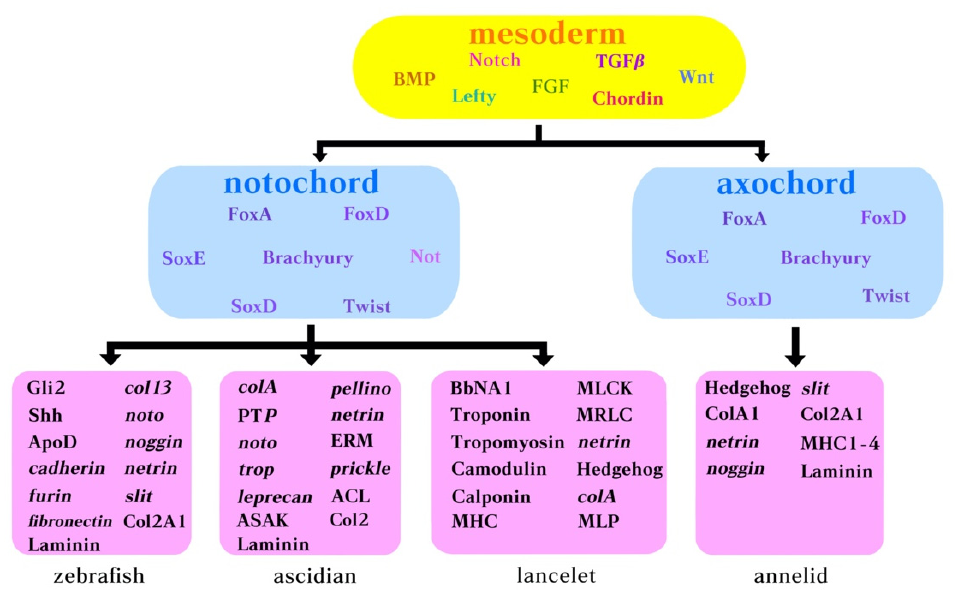
Figure 3. Molecular components belonging to the notochord GNR in ascidians, amphioxus and annelids. Yellow box: body morphogens acting early during development. Pink box: genes expressed by the notochord in zebrafish, ascidian, lancelet (amphioxus), and annelid.